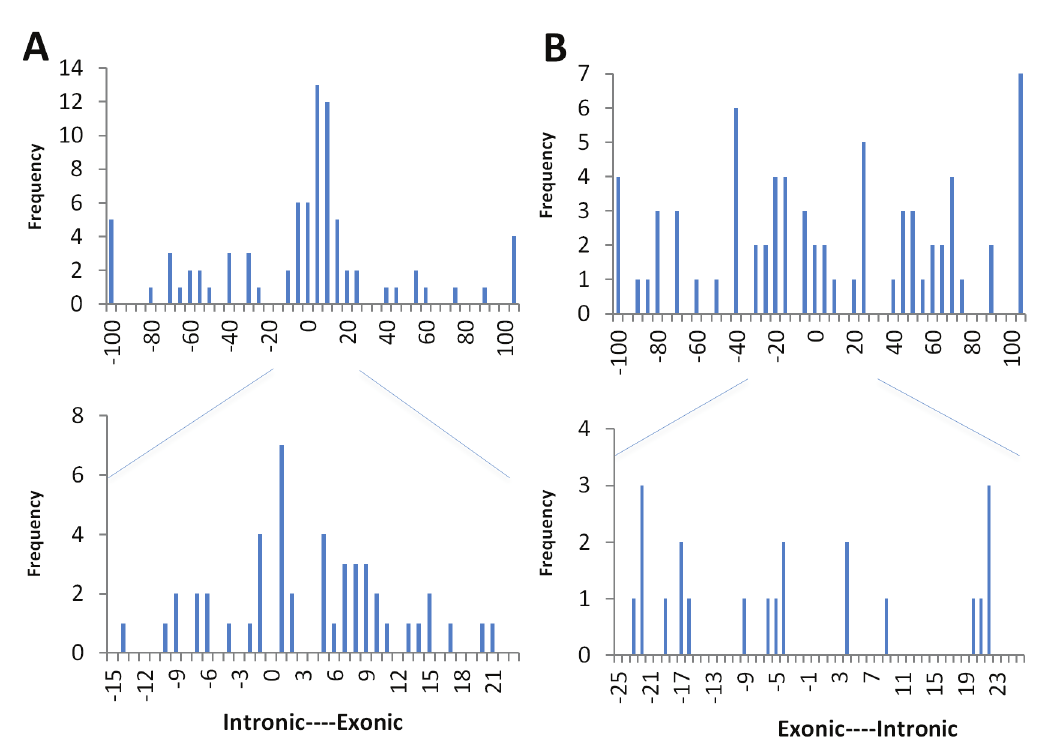
Figure 5. Distribution of activated cryptic sites. The frequency of validated cryptic splice acceptors ( A ) and donors ( B ) occurring at positions relative to the natural splice site. Positions are given using ASSEDA coordinates. Lower two panels magnifies the cryptic site distribution of the region circumscribing the natural splice